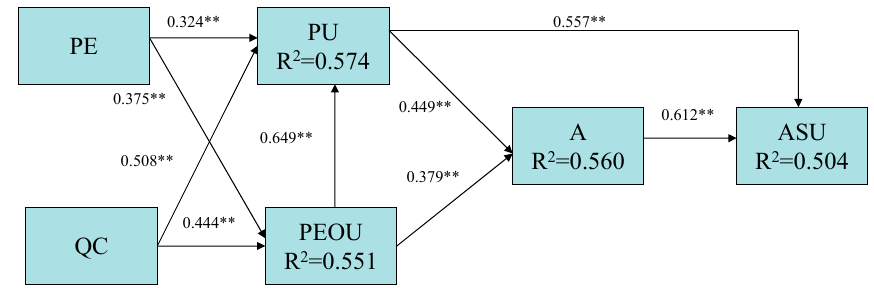
Figure 2. Path analysis of revised technology acceptance model